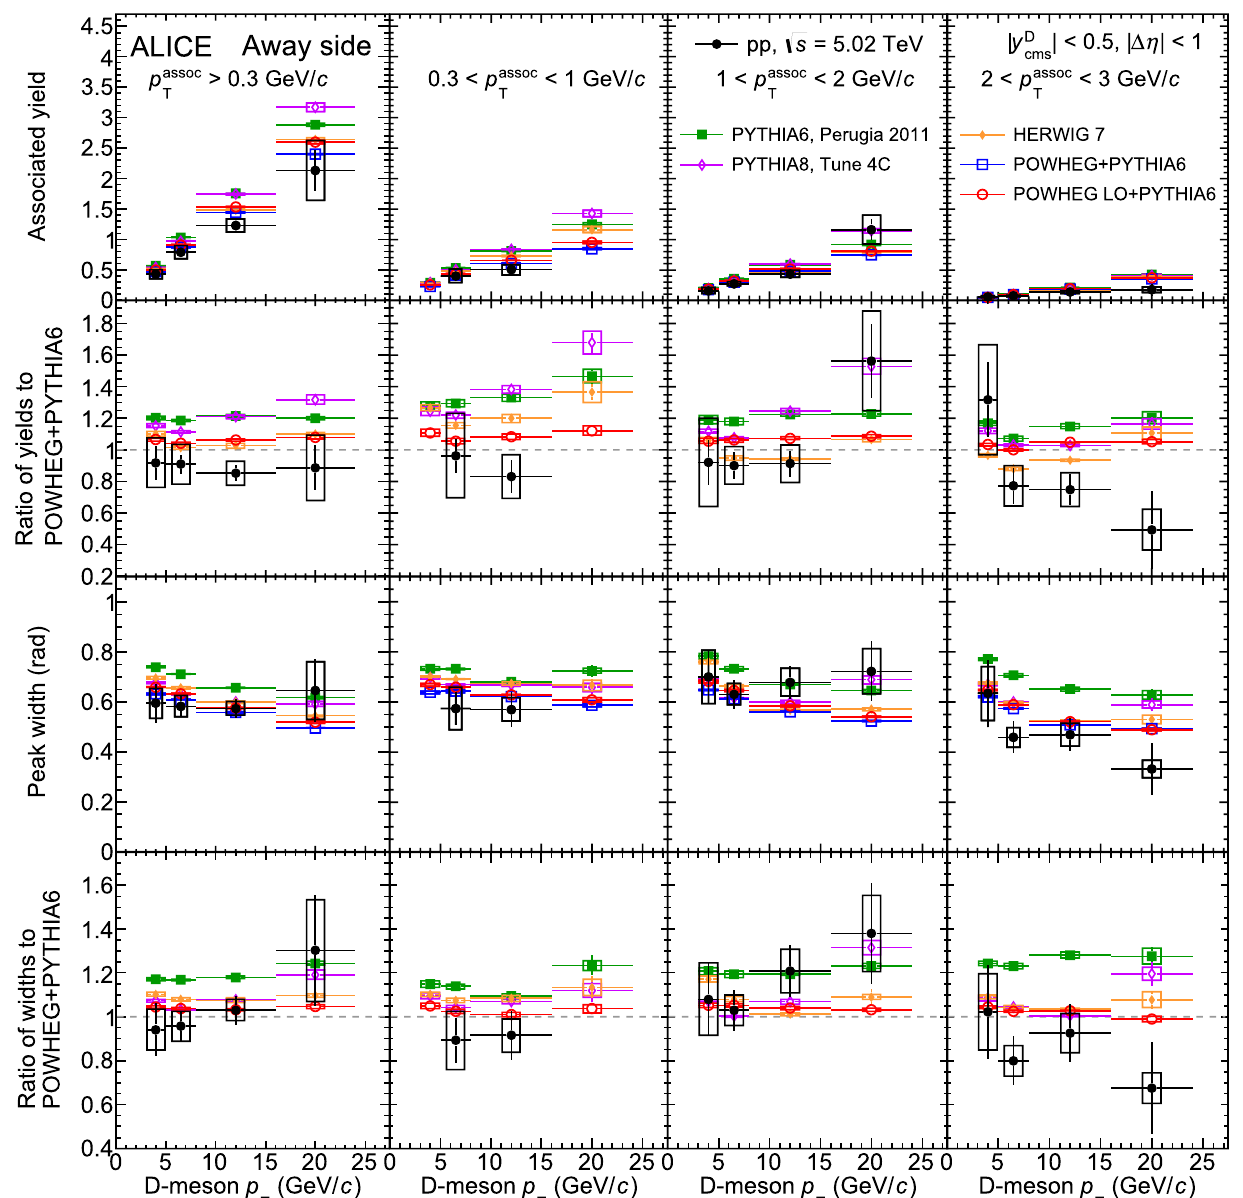
Fig. 10 Measurements of away-side associated peak yields (top row) and widths (third row down) in pp collisions at paredtopredictionsbythePYTHIA,POWHEG+PYTHIA6,POWHEG LO+PYTHIA6, and HERWIG event generators with various configu- rations (see text for details). The ratios of yield (width) values with respect to the predictions by POWHEG+PYTHIA6 are shown in the